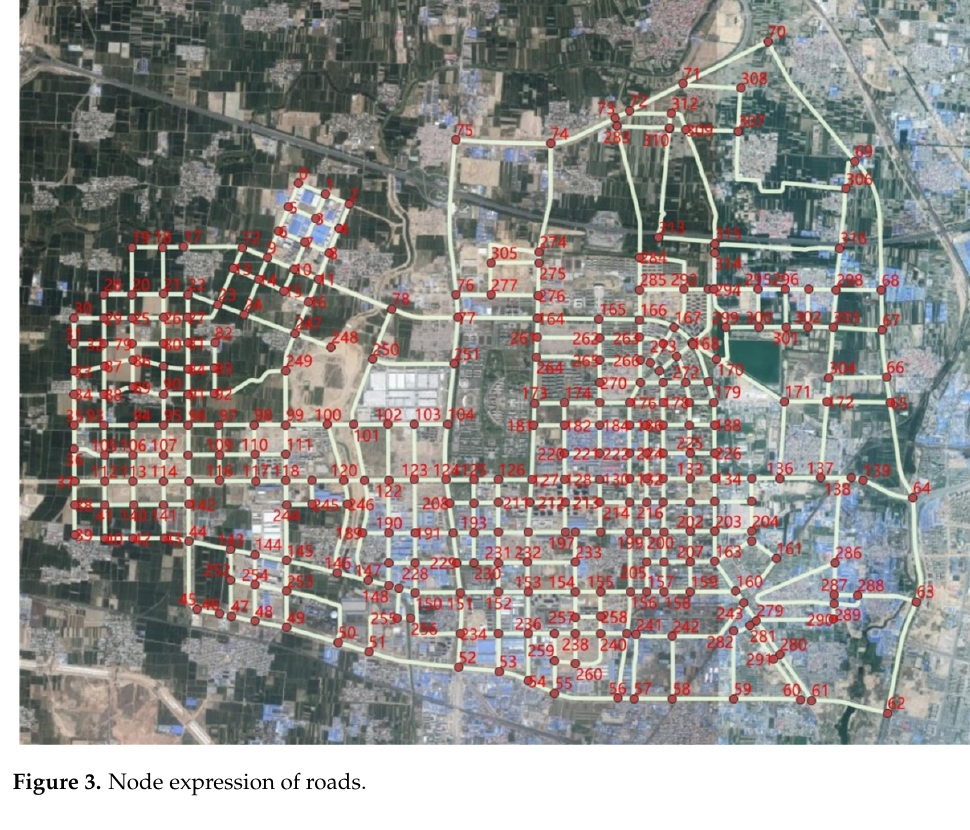
4 of 15 Figure 2. The overall process of bus line network optimization based on ACO. According to Figure 2, the model nodalizes the existing real bus routes based on the completed road nodalization representation. In the network optimization based on ACO, three main decision variables, namely passenger flow, route repetition coefficient, and non-linear coefficient, are added for constraint, where the data fusion process consists of the following 3 main steps before the line network optimization based on ACO. • Road node expression: The purpose of road node expression is to express road data as graph data structure based on road nodes. The specific approach involves the extraction and numbering of key nodes of the roads at the intersection, important road turning points, and end points not connected to other roads (see Figure 3) and then using these nodes to represent the road.